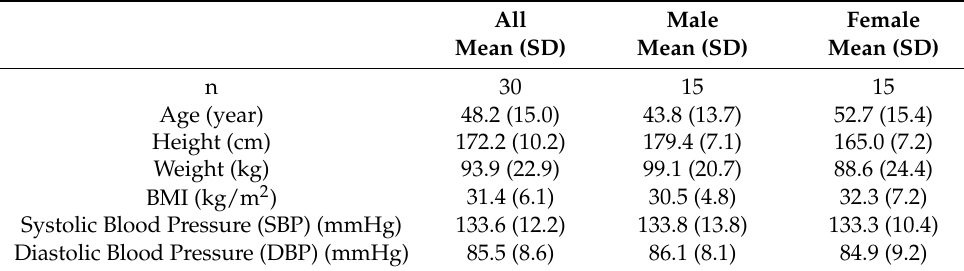
Table 1. Baseline characteristics of all participants who completed at least two intervention